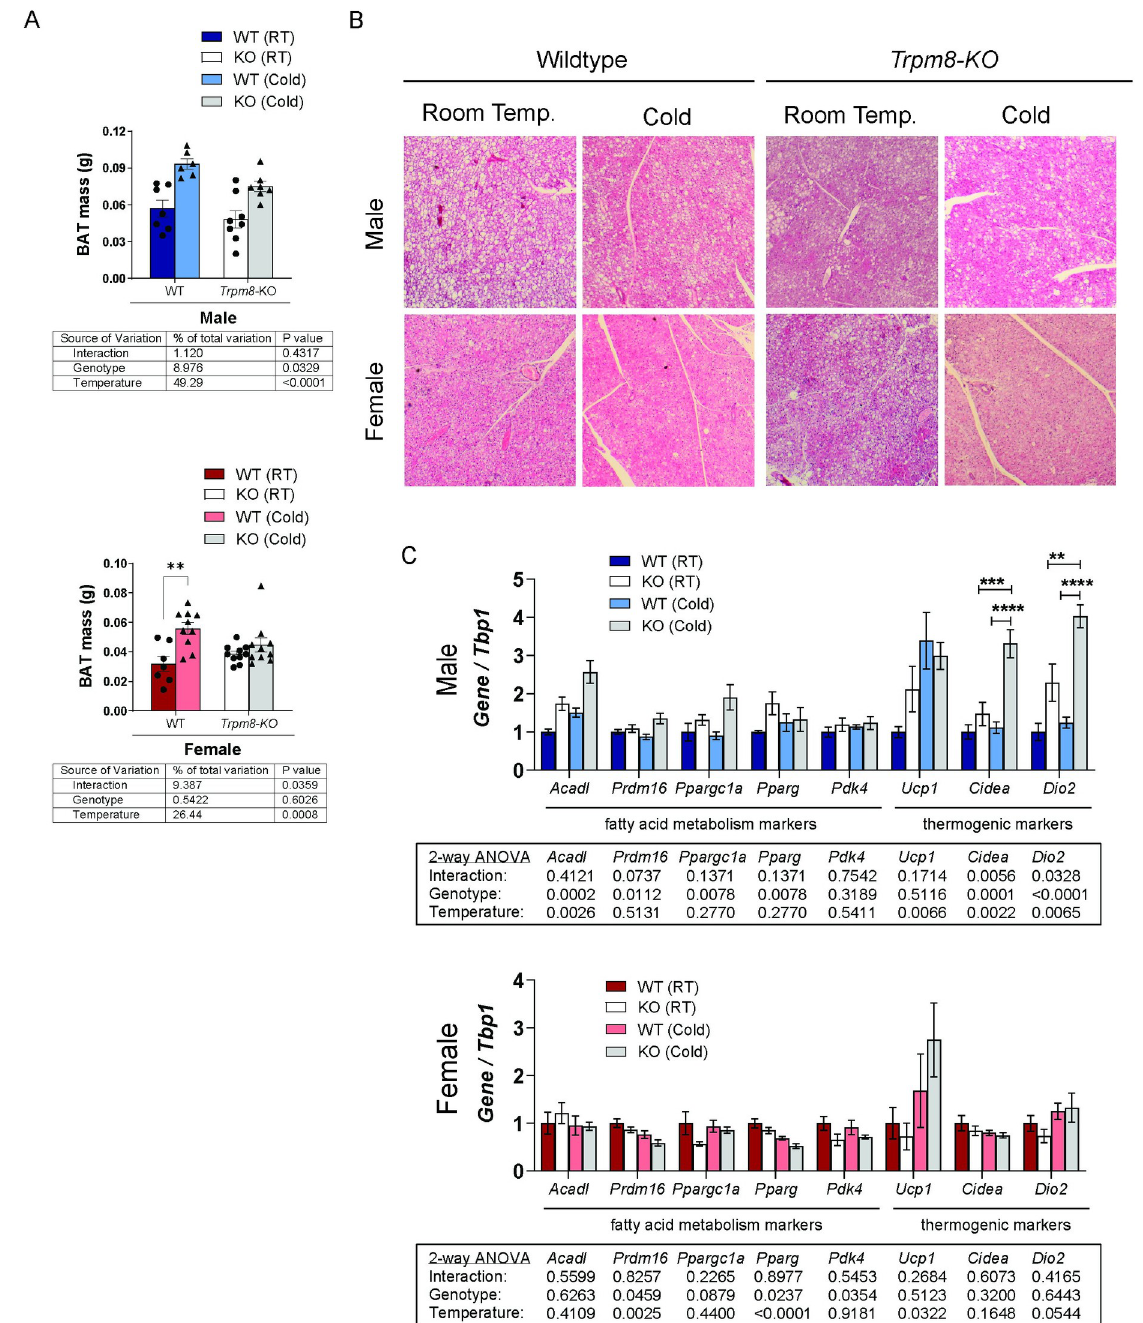
Fig 5. TRPM8 influences the response of BAT to cold temperature. (A) BAT weights from male and female WT and Trpm8-KO housed at 22˚C and 4˚C. N = 6–10. (B) Representative H&E stained image of BAT. N = 5–8. (C) Gene expression of fatty acid metabolism and thermogenic markers in male (top) and female (bottom) BAT. N = 5–6. Data presented as mean ± standard error. � p < 0.05, �� p < 0.01, ��� p < 0.001, ���� p < 0.0001 by Holm-Sidak post hoc test after a significant two-way ANOVA interaction p-